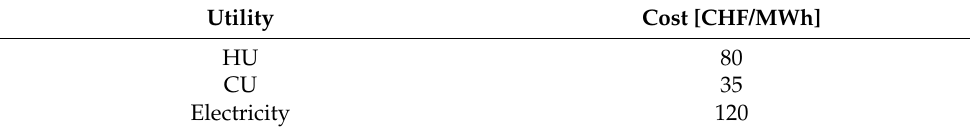
Table 2. Cost function and utility costs for analysis of demonstration case.